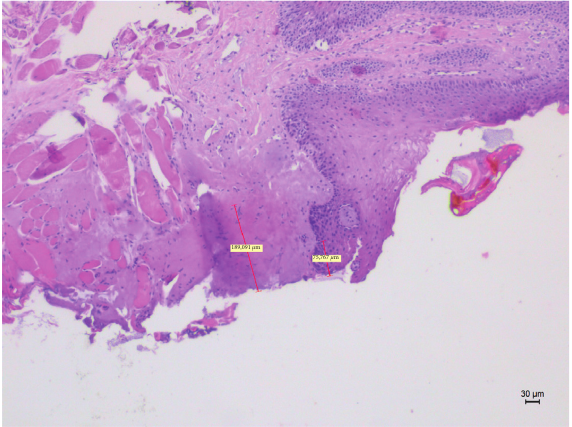
Figure 3: The histological specimen obtained using 4 W in PW with colour EE at 10x magnification (group D).